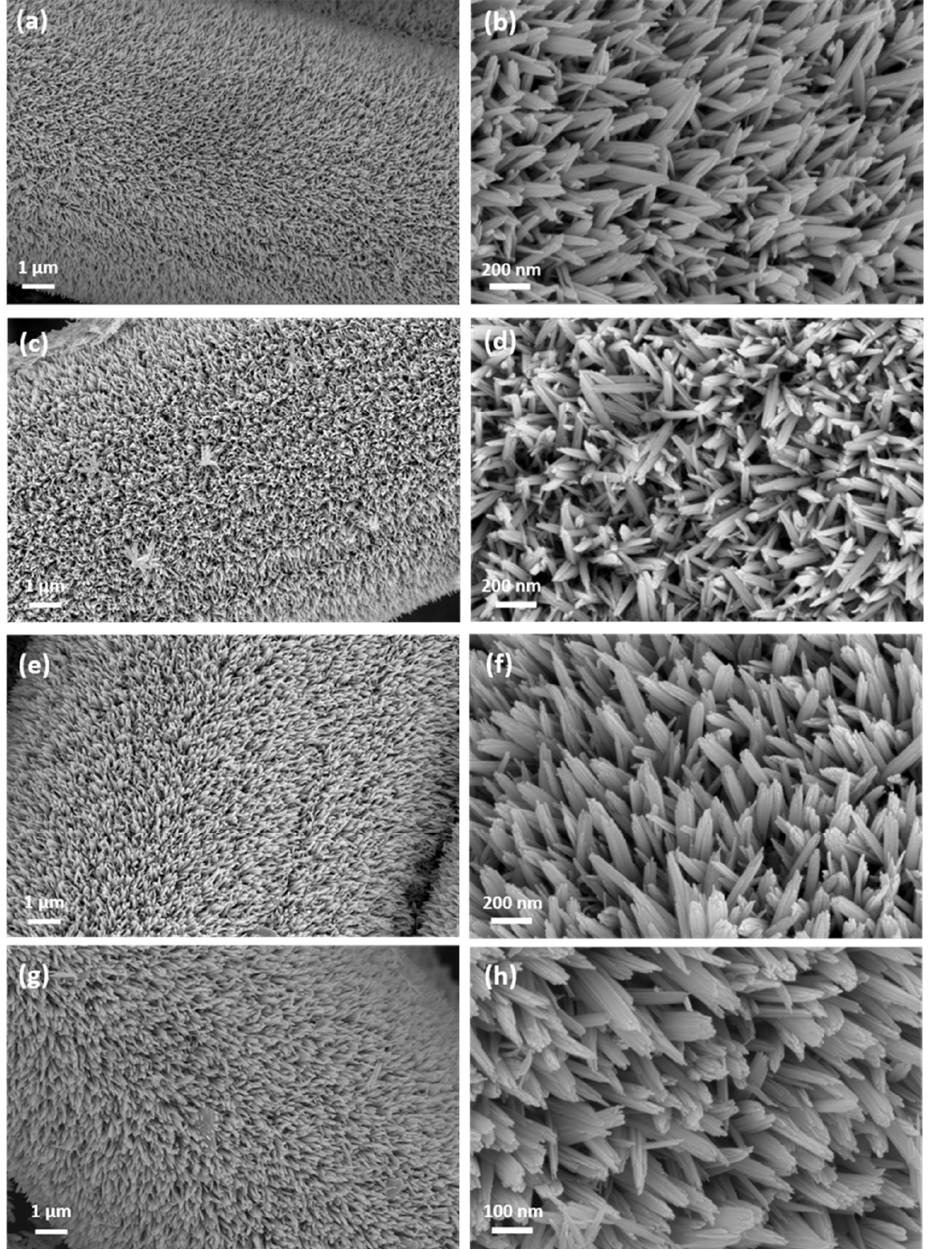
Figure 1. SEM images of ( a , b ) Sr-Fe 2 O 3 @CC, ( c , d ) Ba-Fe 2 O 3 @CC, ( e , f ) Mg-Fe 2 O 3 @CC, and ( g , h ) Ca-Fe 2 O 3 @CC.